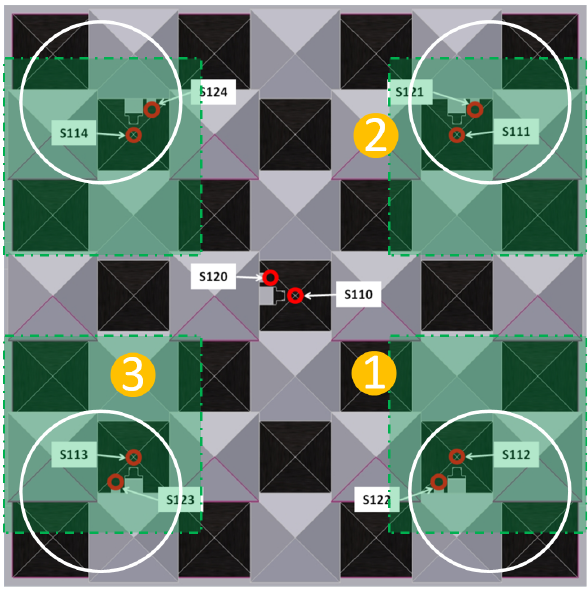
Fig. 6. Array configuration: the little red circles show the locations of the PRTs, the greenish areas indicate the positions of the TECs on the backside of the array, the white circles represent the FOV of the corner pixels of the detector array. The numbered orange spots mark the areas of the spectral measurements.